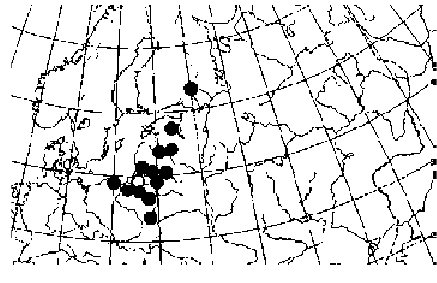
Fig. 2. Distribution of Verrucaria hydrela in Eastern and East Central Europe (cid:2) records more than 50 year old, (cid:3) modern